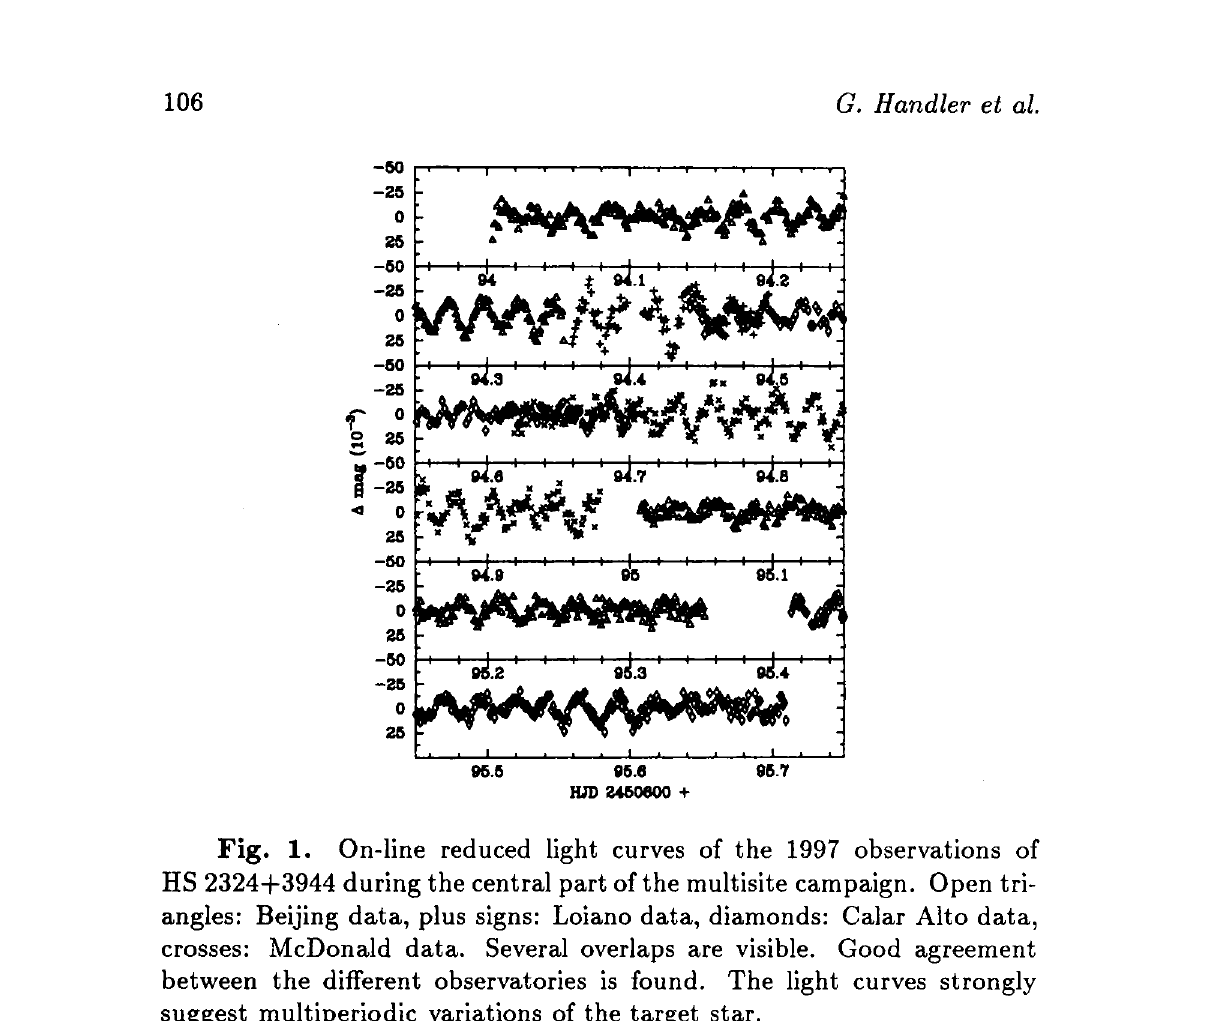
Fig. 1. On-line reduced light curves of the 1997 observations of HS 2324+3944 during the central part of the multisite campaign. Open tri- angles: Beijing data, plus signs: Loiano data, diamonds: Calar Alto data, crosses: McDonald data. Several overlaps are visible. Good agreement between the different observatories is found. The light curves strongly suggest multiperiodic variations of the target